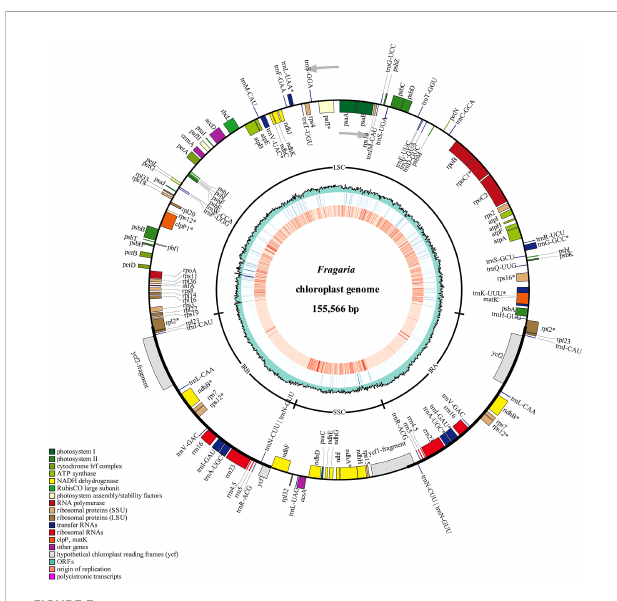
FIGURE 3 Chloroplast genome map of 198 Fragaria accessions. The gene position, quadripartite structure, GC content, density of InDels and SNP distribution were shown from the outer to inner rings. The outermost rectangles represented annotate genes belonging to different functional groups. Gene blocks on the outside and inside the circle indicated the clockwise and anticlockwise transcribed genes,